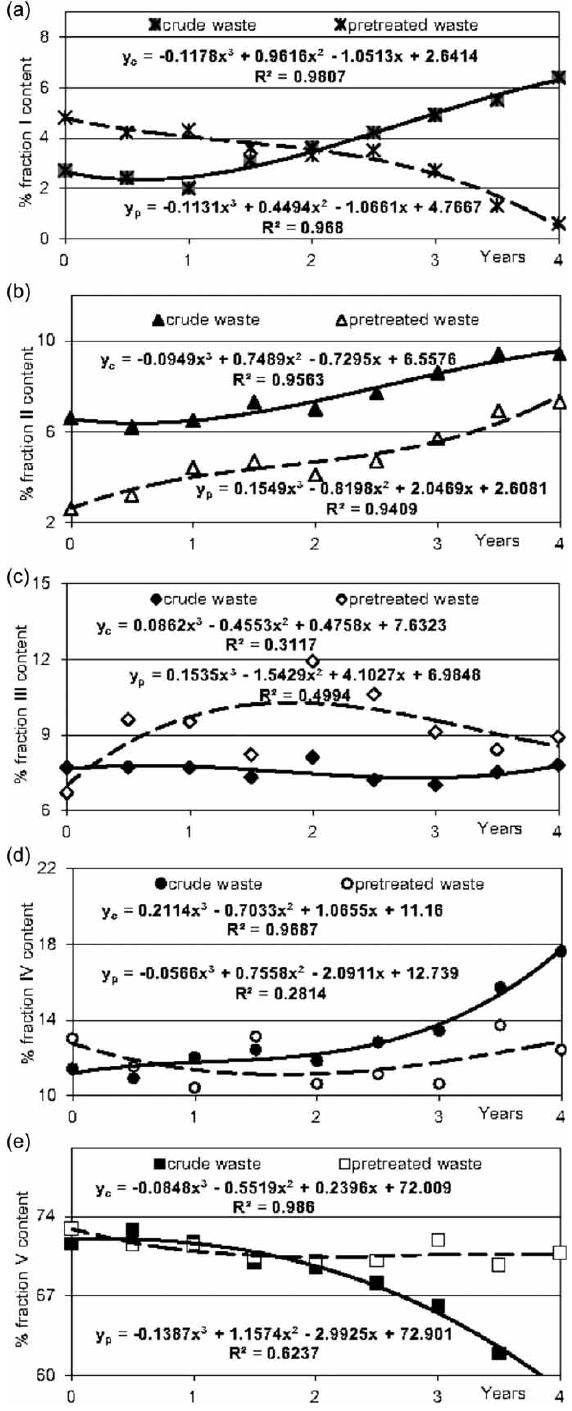
Fig. 2. Changes in the fractional content of cadmium (Cd) in the surface layer of soil from the experimental plots irrigated and fertilized with mixed wastewaters from an oleo-chemical factory (cid:1) defatted raw (solid line of the trend (cid:1) y c ) and pretreated (broken line of the trend (cid:1) y p ) (C 0(Cd) (cid:1) 0.6 9 0.2 mg/kg d.m.). Individual fractions are given in diagrams: (a) fraction I (cid:1) exchanged, (b) fraction II (cid:1) carbonate, (c) fraction III (cid:1) connected with hydrated oxides of manganese and iron, (d) fraction IV (cid:1) organic,e) fraction V (cid:1) the